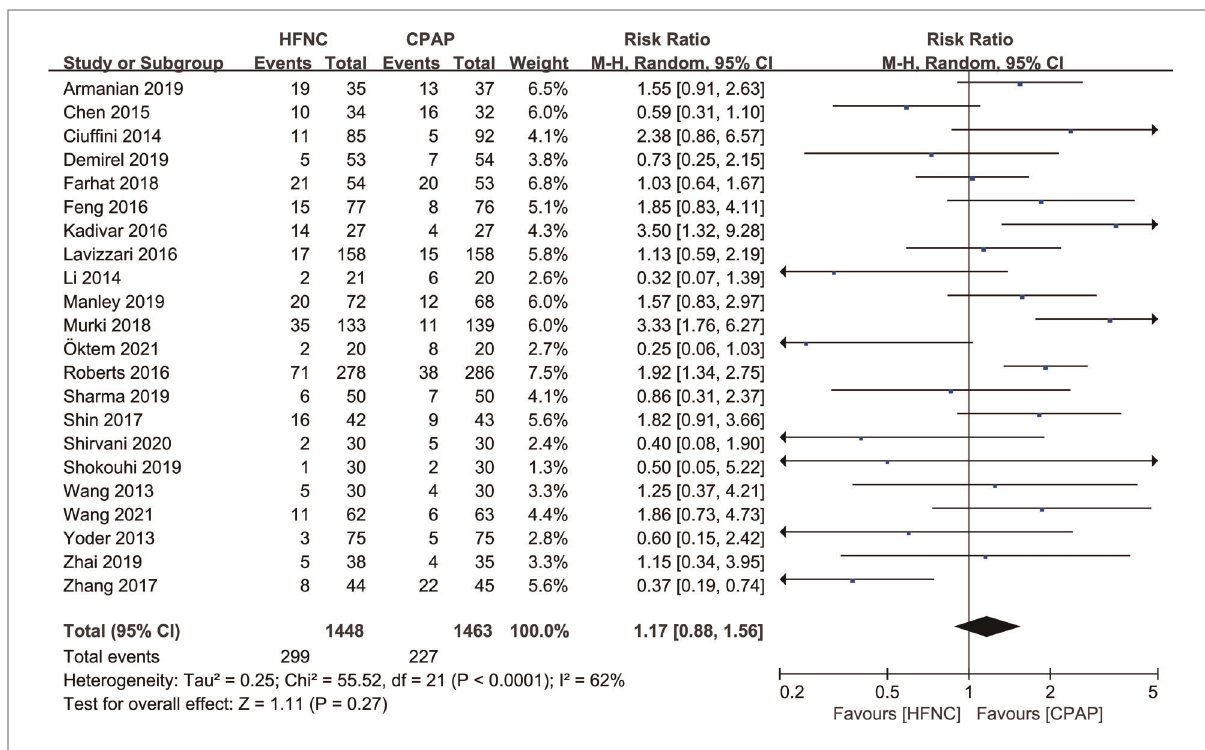
FIGURE 4 Forest plot of comparison: HFNC vs. CPAP-number-respiratory support failure.